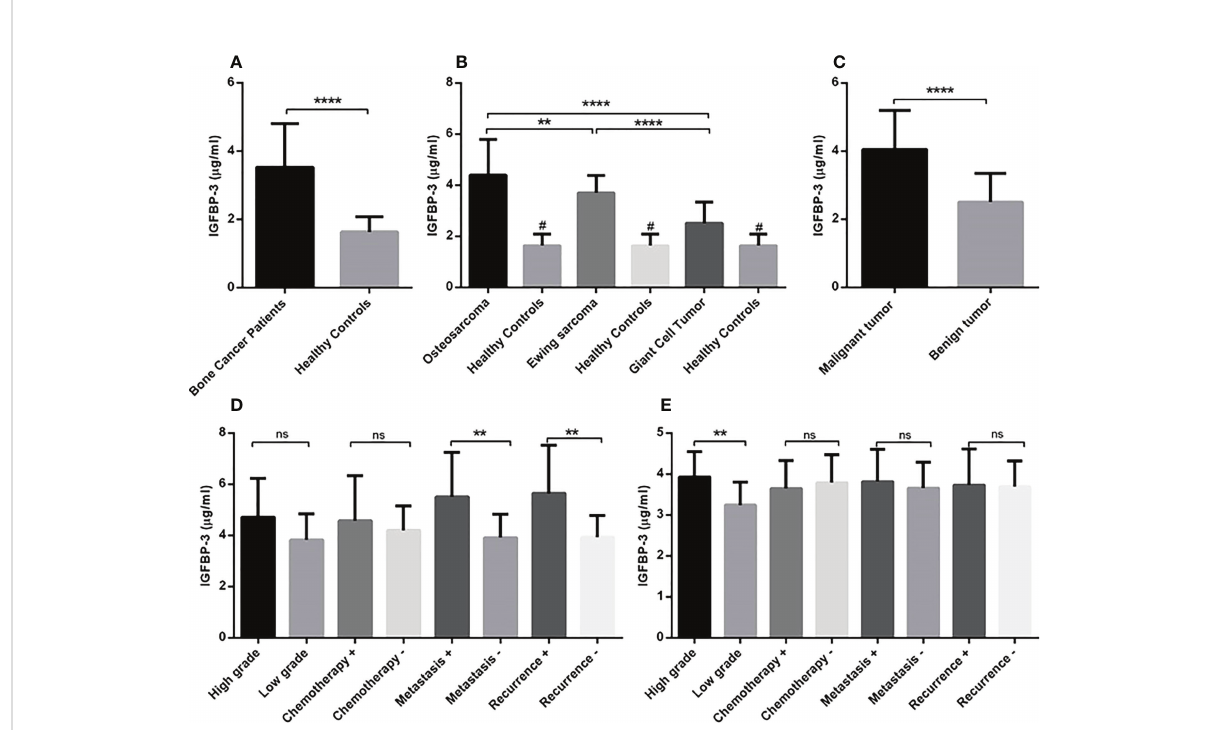
FIGURE 6 The IGFBP-3 level in patients with primary bone tumors. Patients with bone tumors (N=90) showed a higher level of IGFBP-3 in the serum compared to healthy subjects (N=30) (A) . A signi fi cant elevation of IGFBP-3 was detected in osteosarcoma (N=30), Ewing sarcoma (N=30) and GCT (N=30) compared to healthy subjects (N=30) also osteosarcoma and Ewing sarcoma group compared to GCT group (B) . The IGFBP-3 level in patients with malignant tumors (N=60) was considerable compared to the benign group (N=30) of tumors (C) . Patients with metastatic (N=9) and recurrent (N=8) osteosarcoma tumors (D) and patients with high-grade (N=20) Ewing sarcoma tumors expressed a higher level of IGFBP-3 compared to their opposite counterparts (E) . The number of examined samples in each tumor subtype is shown in Supplementary Table 1. The statistical differences between groups are shown as asterisks (**P <0.01, ****P <0.0001), and (ns) indicates unspeci fi c. (#) indicates P<0.0001 for comparing osteosarcoma, Ewing sarcoma, and GCT with healthy